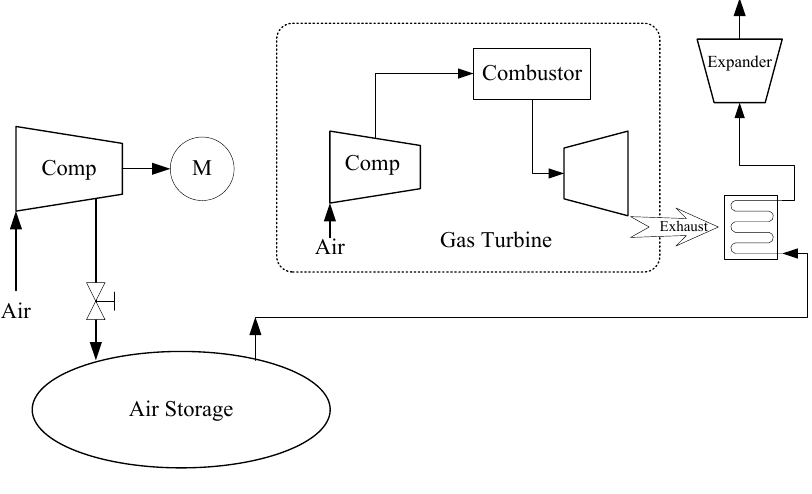
Figure 2. Diagram of the second-generation CAES